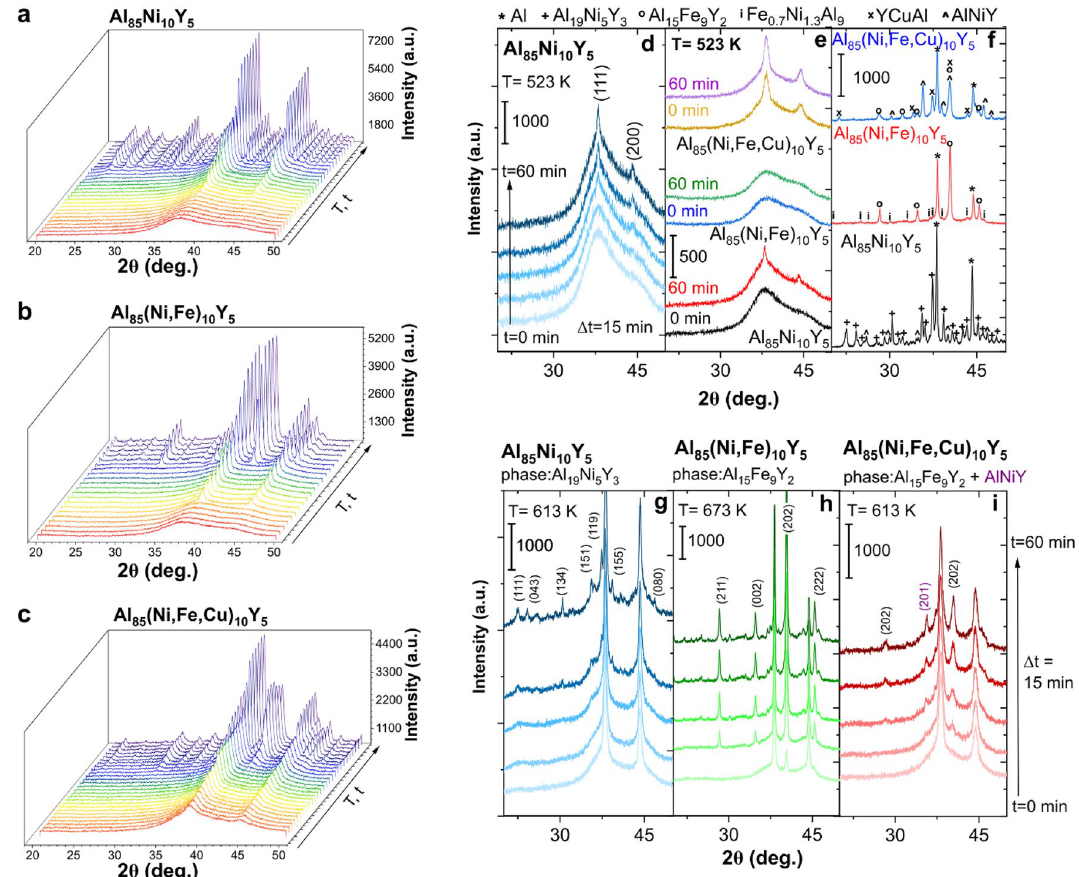
Figure 3. In-situ XRD patterns in temperature and time-domain recorded for ( a ) Al 85 Ni 10 Y 5 , ( b ) Al 85 (Ni, Fe) 10 Y 5 , and ( c ) Al 85 (Ni, Fe, Cu) 10 Y 5 amorphous alloys; ( d ) time-dependent crystallization of Al phase presented in in-situ XRD patterns of Al 85 Ni 10 Y 5 amorphous alloy at a constant temperature equal to 523 K; ( e ) comparison of the thermal stability of amorphous phase at a constant temperature equal to 523 K for 0 and 60 min of heating; ( f ) phase composition of fully crystallized amorphous alloys (the markings explained above the graphics); ( g ) crystallization of the second (Al 19 Ni 5 Y 3 ) phase in Al 85 Ni 10 Y 5 visualized in the time domain at T = 613 K; ( h ) crystallization of the second (Al 15 Fe 9 Y 2 ) phase in Al 85 (Ni, Fe) 10 Y 5 visualized in the time domain at T = 673 K; ( i ) spontaneous crystallization of the second (Al 15 Fe 9 Y 2 ) and third (AlNiY) phases in Al 85 (Ni, Fe, Cu) 10 Y 5 visualized in the time domain at T = 613